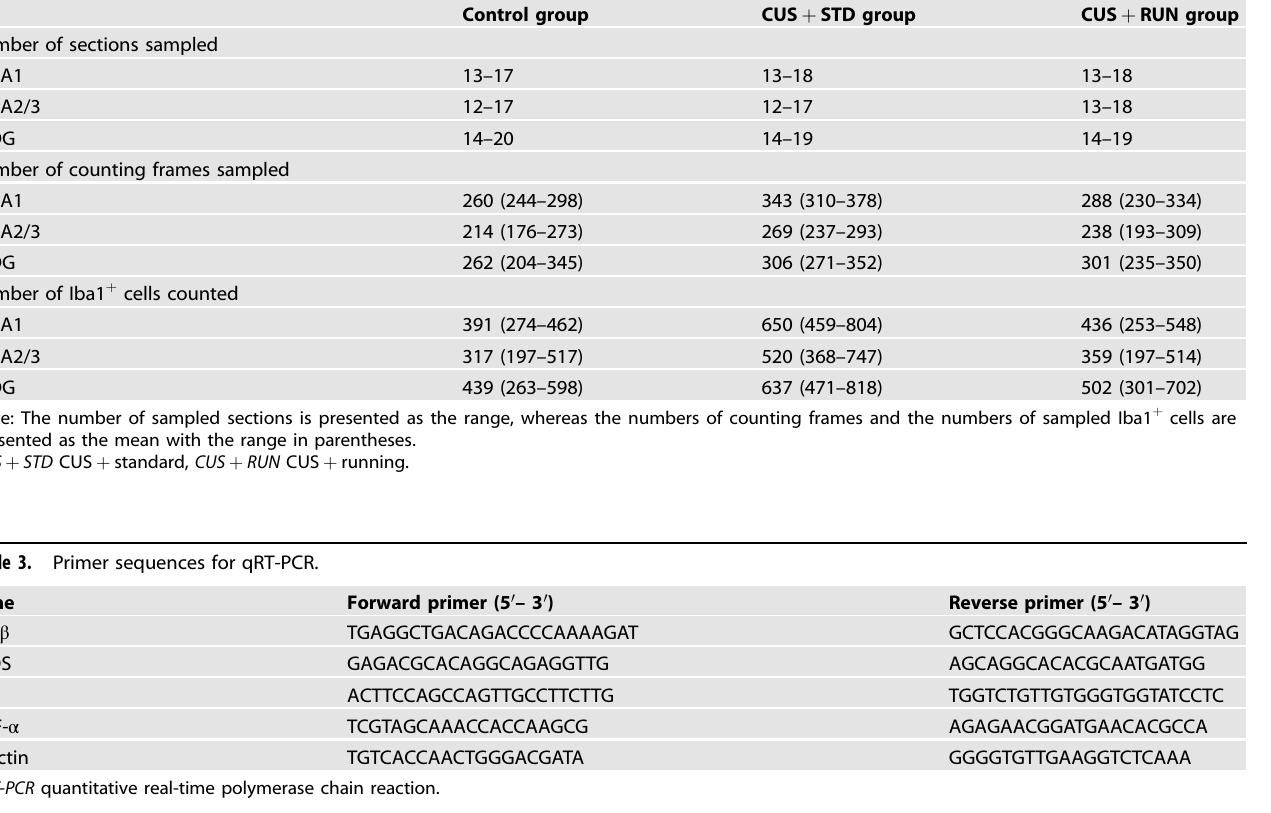
Table 2. Sampling scheme for the estimation of the number of Iba1 + cell.